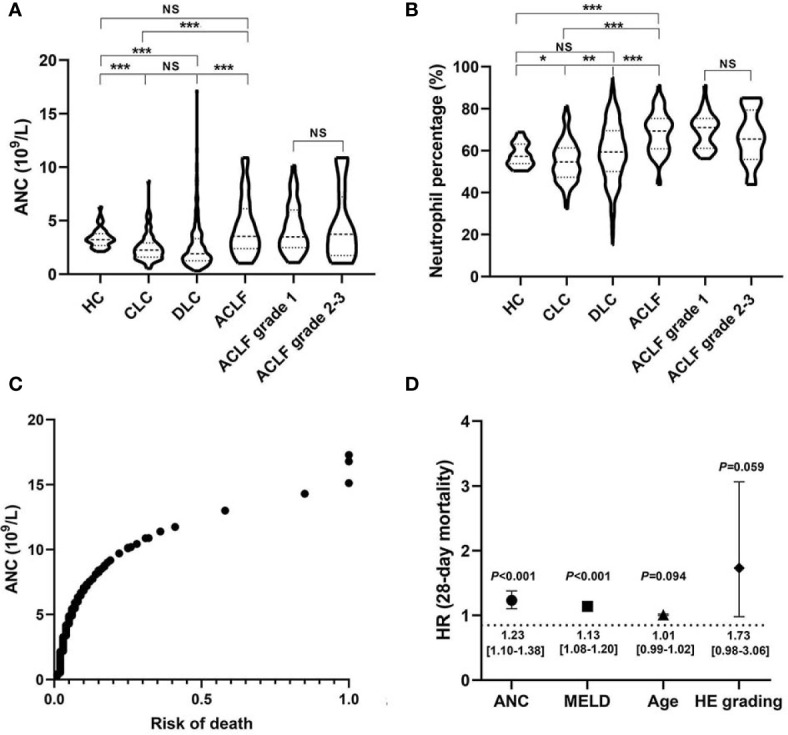
Circulating neutrophil quantity and viability alterations in hepatitis B virus related acute-on-chronic liver failure (HBV-ACLF) patients. (A, B) Comparison of absolute counts and percentages of circulating neutrophils among patients with HBV-ACLF (N=63), decompensated liver cirrhosis (DLC) (N=475), compensated liver cirrhosis (CLC) (N=95), and healthy controls (HCs) (N=34), as well as the comparison between early ACLF (grade 1; N=44) and advanced ACLF (grade 2-3; N=19). Statistical analysis was performed by One-way ANOVA (LSD method for Post-hoc analysis) or Student t test. Data are expressed as mean ± standard deviation (SD). (C) The association between absolute neutrophil count (ANC) and 28-day risk of death in patients with HBV-related cirrhosis (N=633). Statistical analysis was performed by Cox proportional hazard model. (D) Independent 28-day risk factors for death in patients with HBV-related cirrhosis and their risk estimates with 95%CI. Statistical analysis was performed by the Mann-Whitney u test. Data are expressed as mean ± standard deviation (SD). HE, Hepatic encephalopathy; MELD, Model end-stage liver disease. NS, P > 0.05; *0.01 ≤ P < 0.05; **0.001 ≤ P < 0.01; ***P < 0.001.